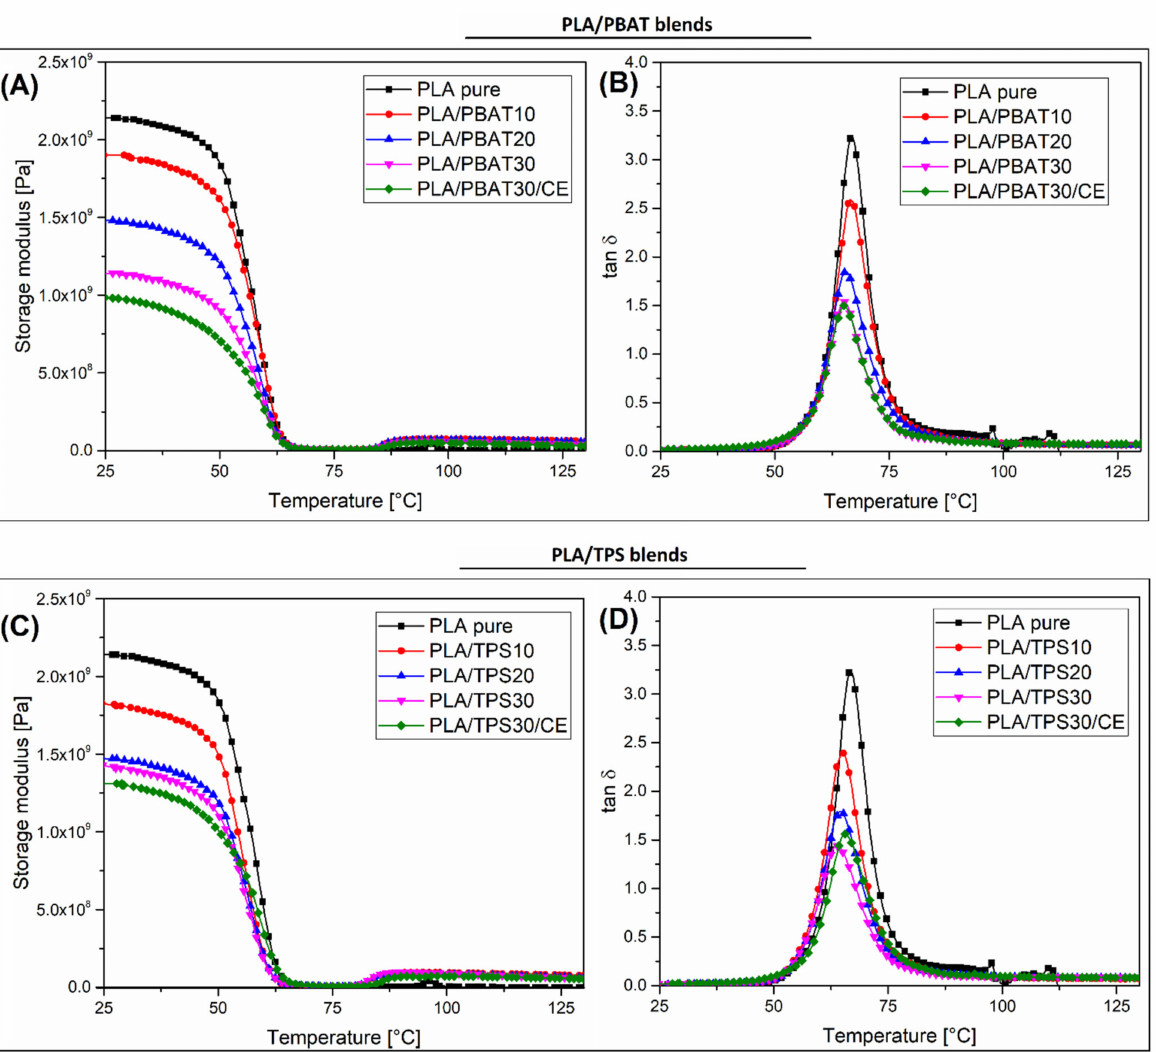
Figure 10. The DMTA thermograms obtained for the injection-molded samples: ( A , B ) storage modulus and tan δ plots for PLA/PBAT-based samples, and ( C , D ) results for the PLA/TPS-based